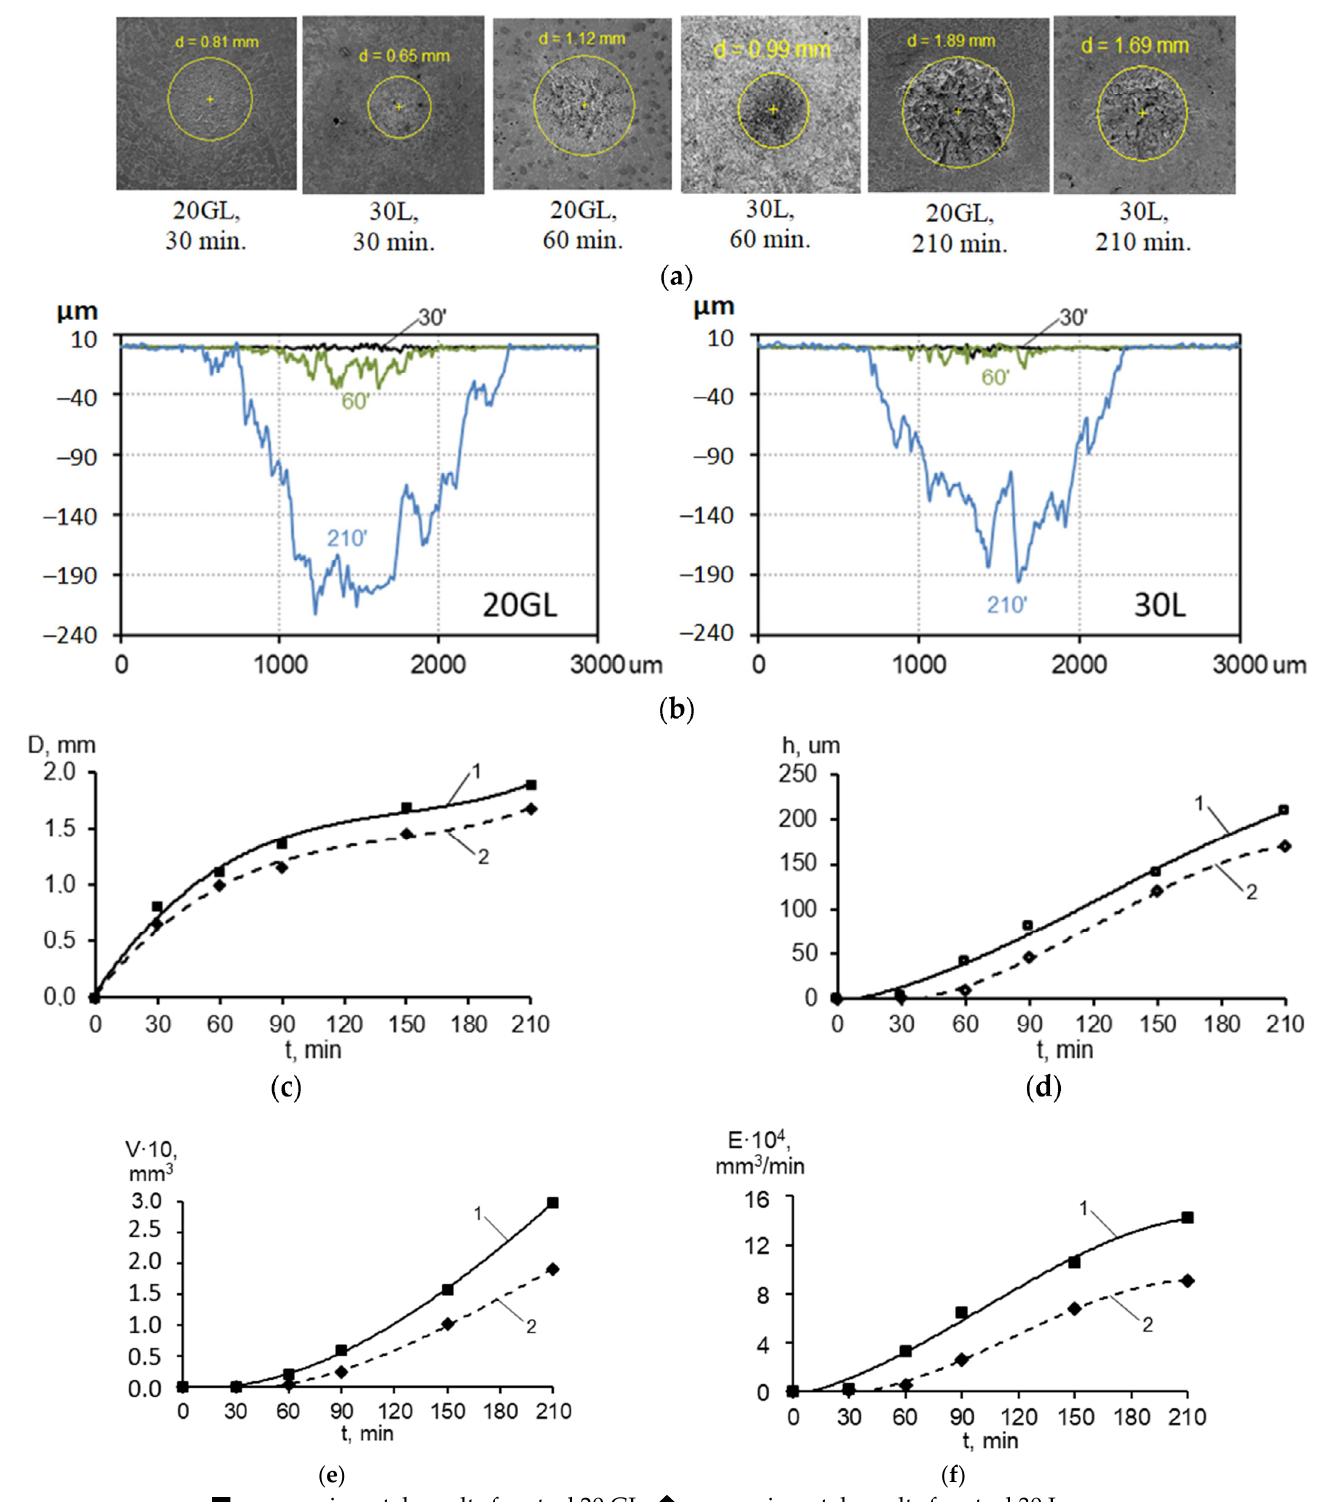
Figure 8. Patterns of surface changes in cavitation mark area ( a ), surface profiles ( b ), diameter of cavitation mark D out ( c ), depth of cavitation mark h ( d ), volume removal V ( e ), and removal rate E ( f ) determined by them at cavitation test of steel 20 GL (1) and 30 L (2) samples (nozzle diameter 0.85 mm, distance to nozzle 15 mm, inlet pressure 18 MPa, outlet pressure 0.1 MPa, cavitation number 0.0055, temperature 50 °C).